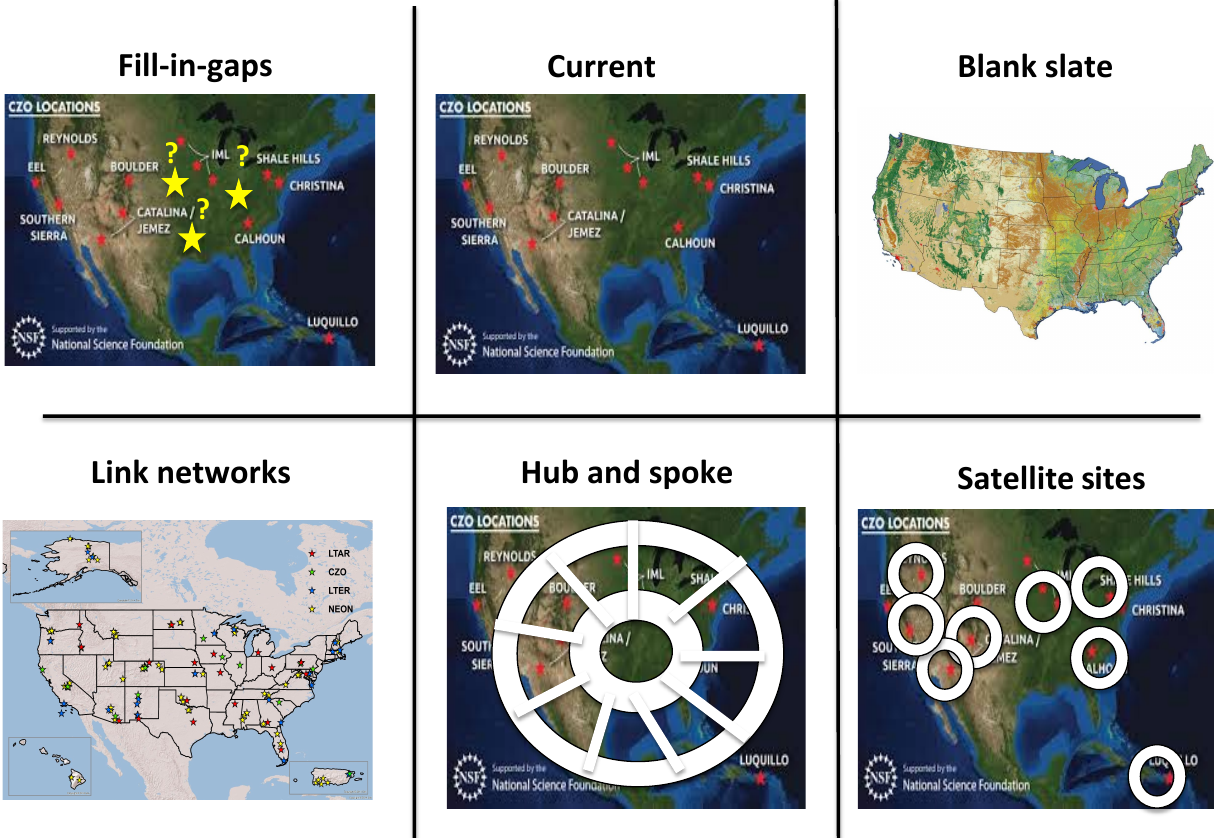
Figure 5. Conformations of a future CZO network discussed in the text. The most effective topology is likely to be a combination of the observatory framework with smaller campaign-style science as discussed in the text, i.e., a hubs-and-campaign strategy. LTAR – Long- Term Agroecosystem Research; CZO – Critical Zone Observatory; LTER – Long-Term Ecological Research; NEON – National Ecological Observatory